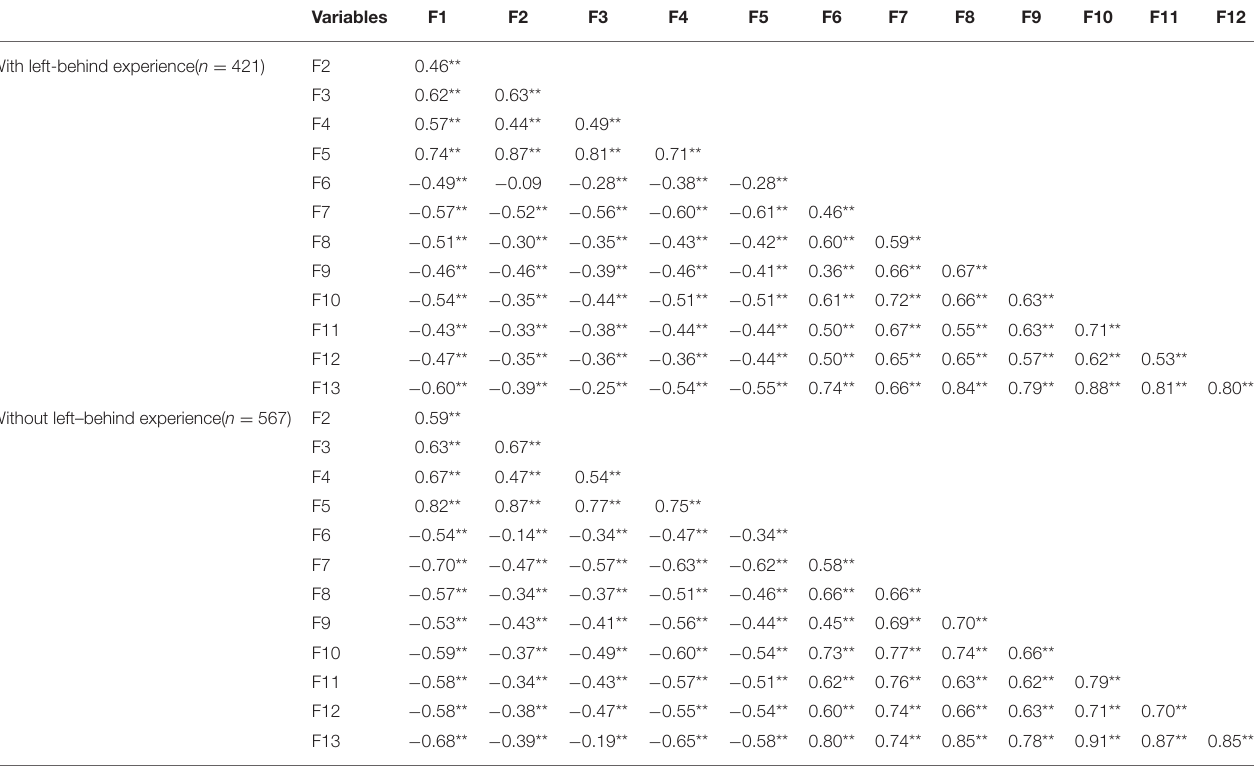
TABLE 4 | Correlation analysis of life meaning and social adaptation. Variables F1 F2 F3 F4 F5 F10 F11 F12 With left-behind experience( n = 421)